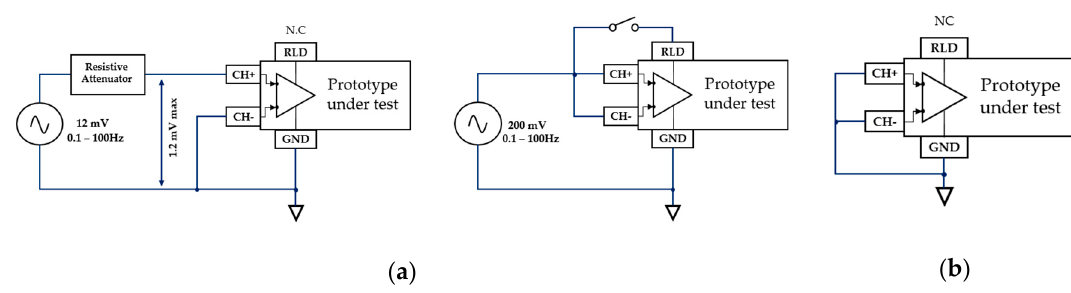
Figure 13. Common mode rejection ratio (CMRR) and noise experimental determination: ( a ) circuits for differential and common mode gain measurement; ( b ) measurement of input noise.